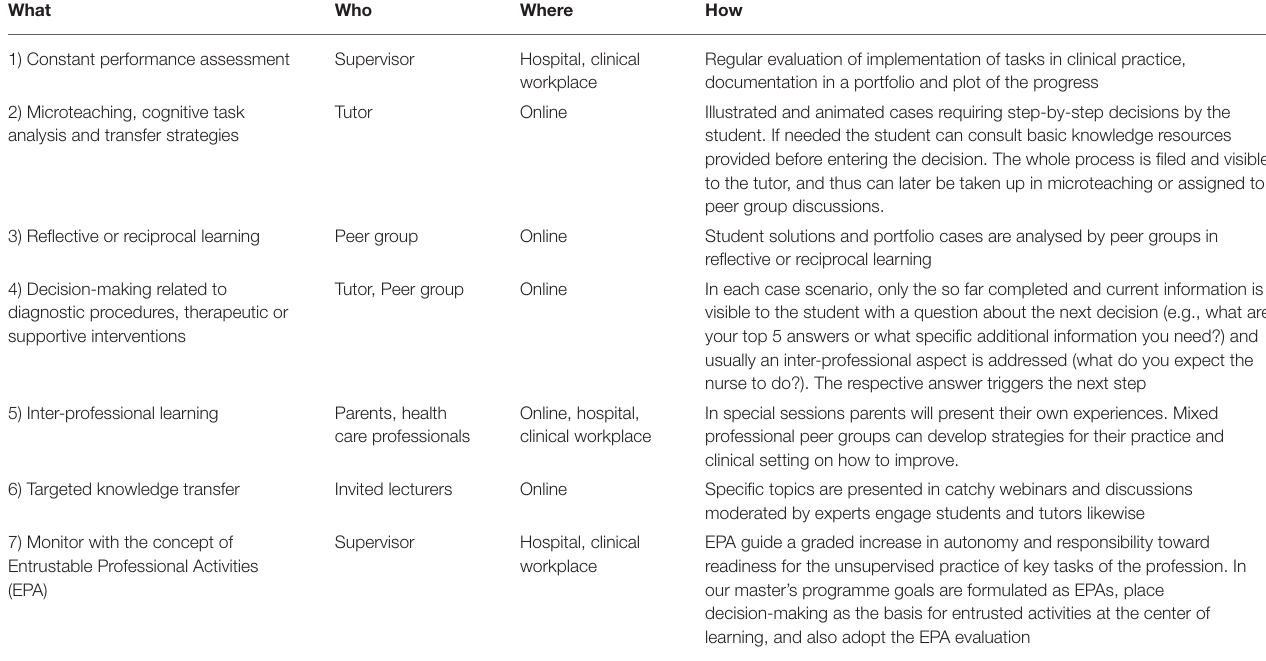
TABLE 1 | Training techniques in the master of